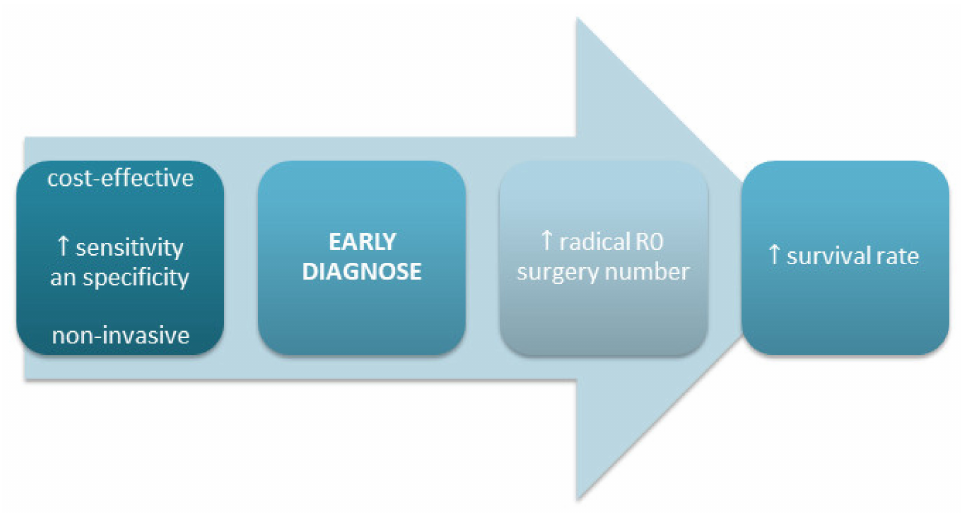
Figure 1. Features of ideal PDAC biomarkers